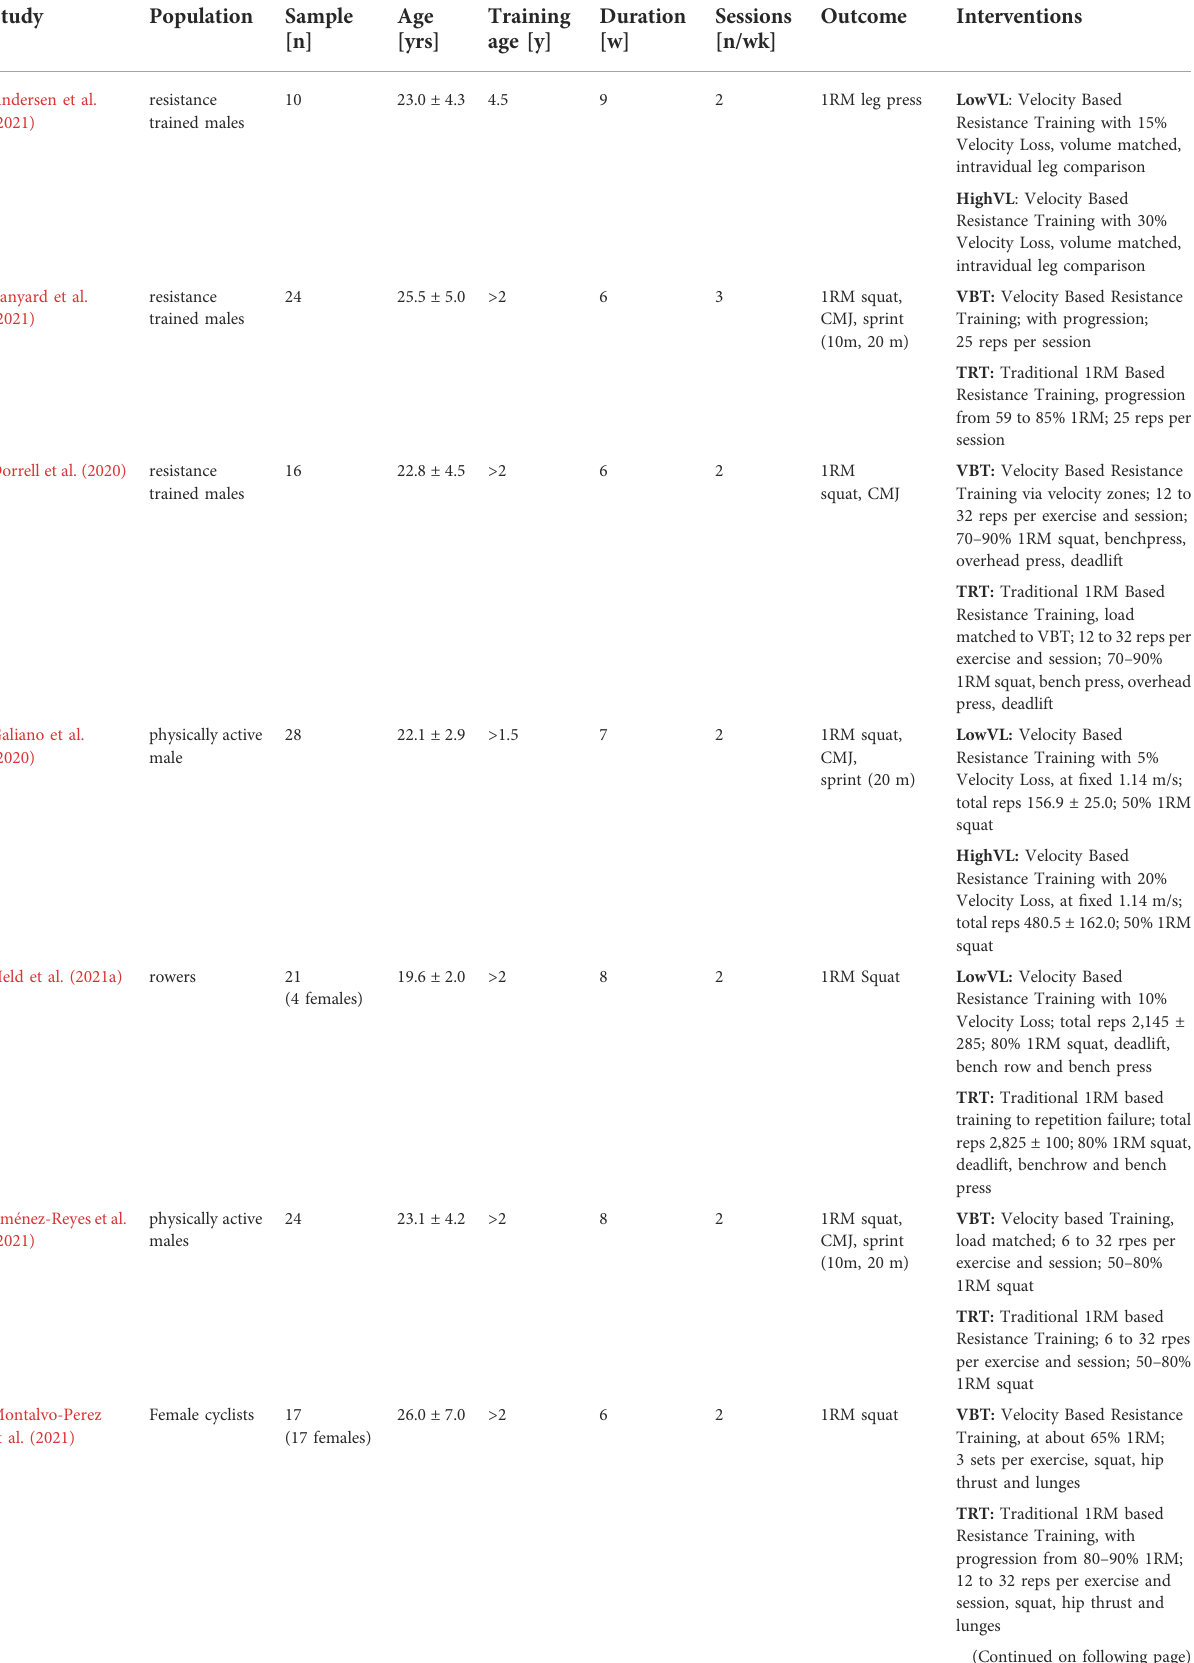
TABLE 2 Overview of the included